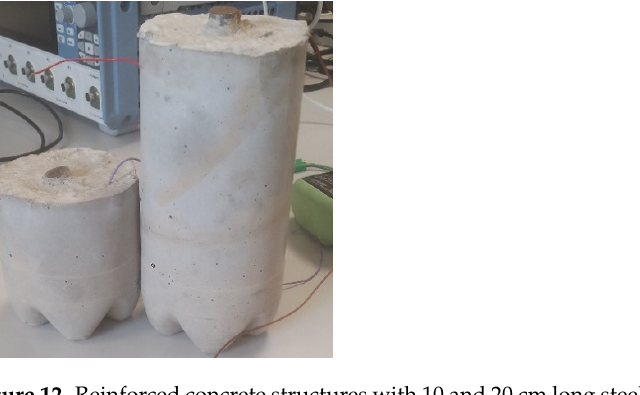
Figure 12. Reinforced concrete structures with 10 and 20 cm long steel with a concrete cover thick- ness of 40